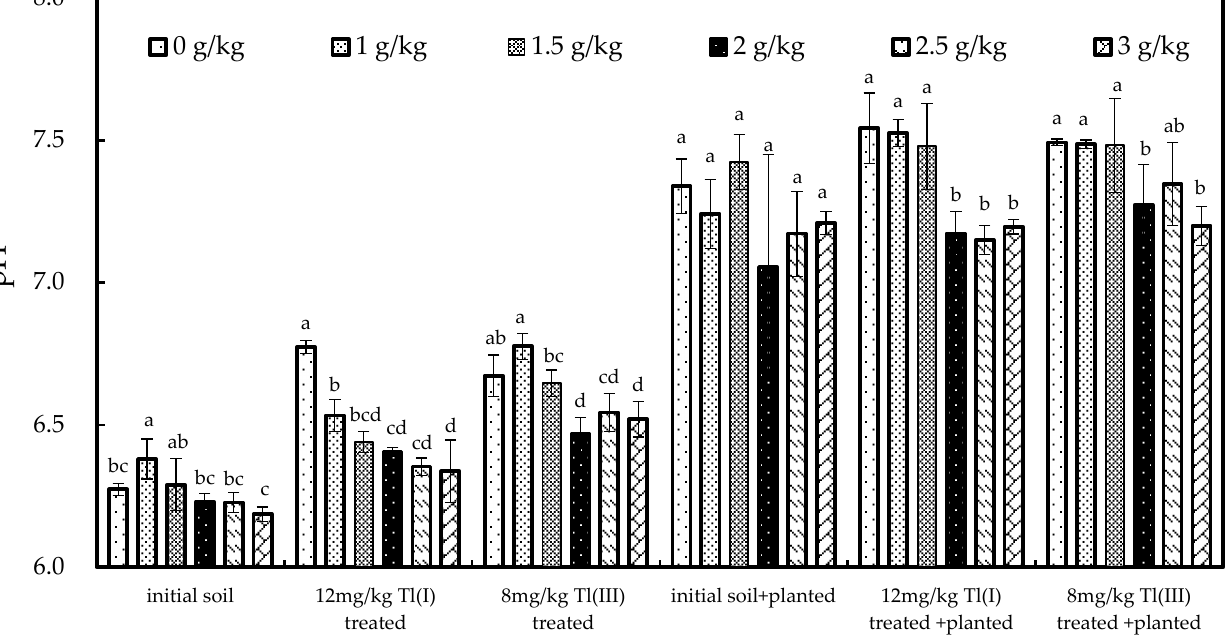
Figure 7. The pH values of soil before and after the experiment. Bars denote standard deviation from means of three replicates. Significant differences among different Ca treatments are indicated by lowercase ( p < 0.05).